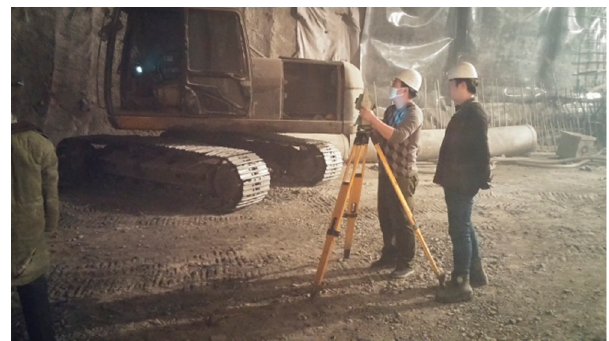
Figure 27. Total station measurement.